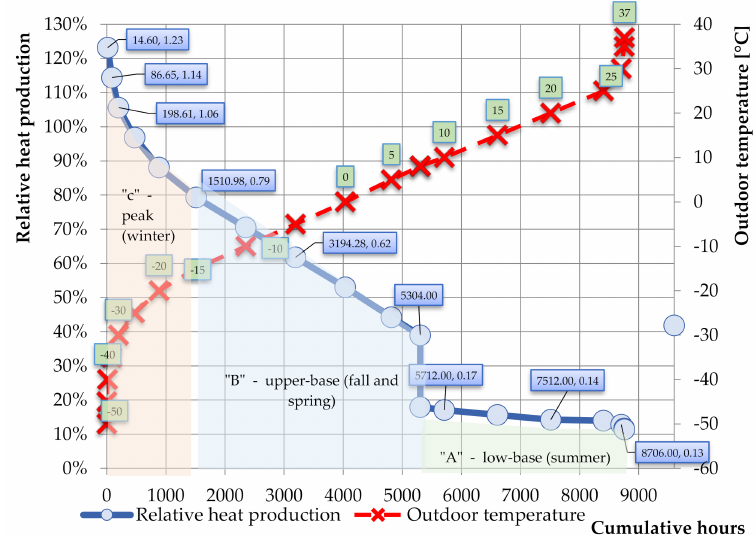
Figure 2. Heat production and average annual outdoor temperatures during